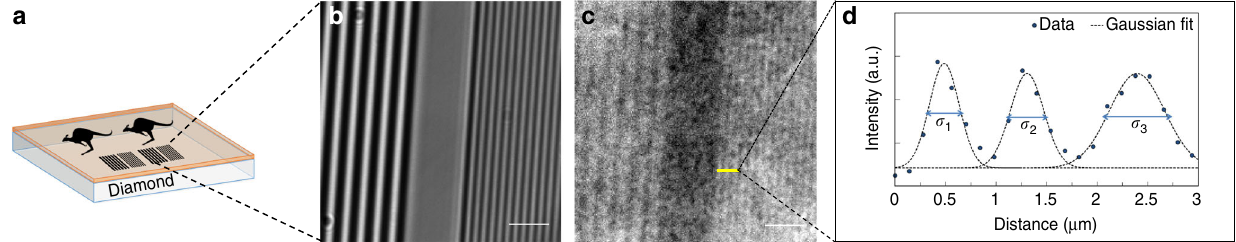
Fig. 4 Spatial resolution of quantum probe relaxation microscopy. a Schematic diagram of the diamond with patterned PMMA layers. b Bright- fi eld image of the grating mask used to determine the image resolution. b Single τ sp image of Cu 2+ ions at 460 G ( τ sp = 124 µ s, n = 12 × 10 6 ). The light regions indicate areas of Cu 2+ . Scale bar in b , c is 5 µ m. d Line cut through a section of the quantum probe relaxation image ( yellow line ). The Gaussian fi t to each peak in the line scan shows linewidths of σ 1 = 290 ± 30, σ 2 = 330 ± 40 and σ 3 = 540 ± 60 nm. The minimum linewidth is consistent with the diffraction limit of the microscope, ∼ 305 nm